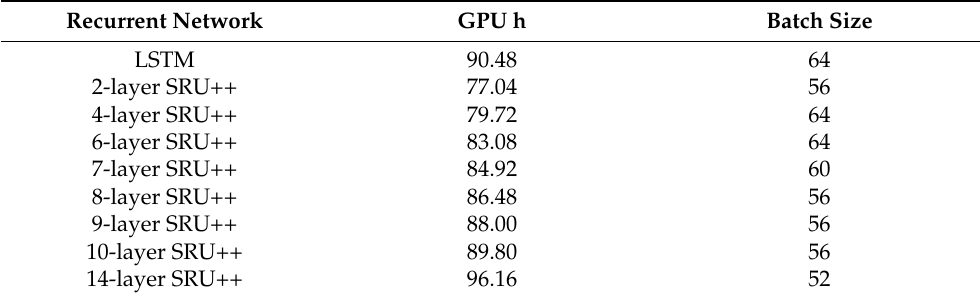
Table A4. The training GPU hours used by VibDenoiser with different recurrent layers. The training epoch was